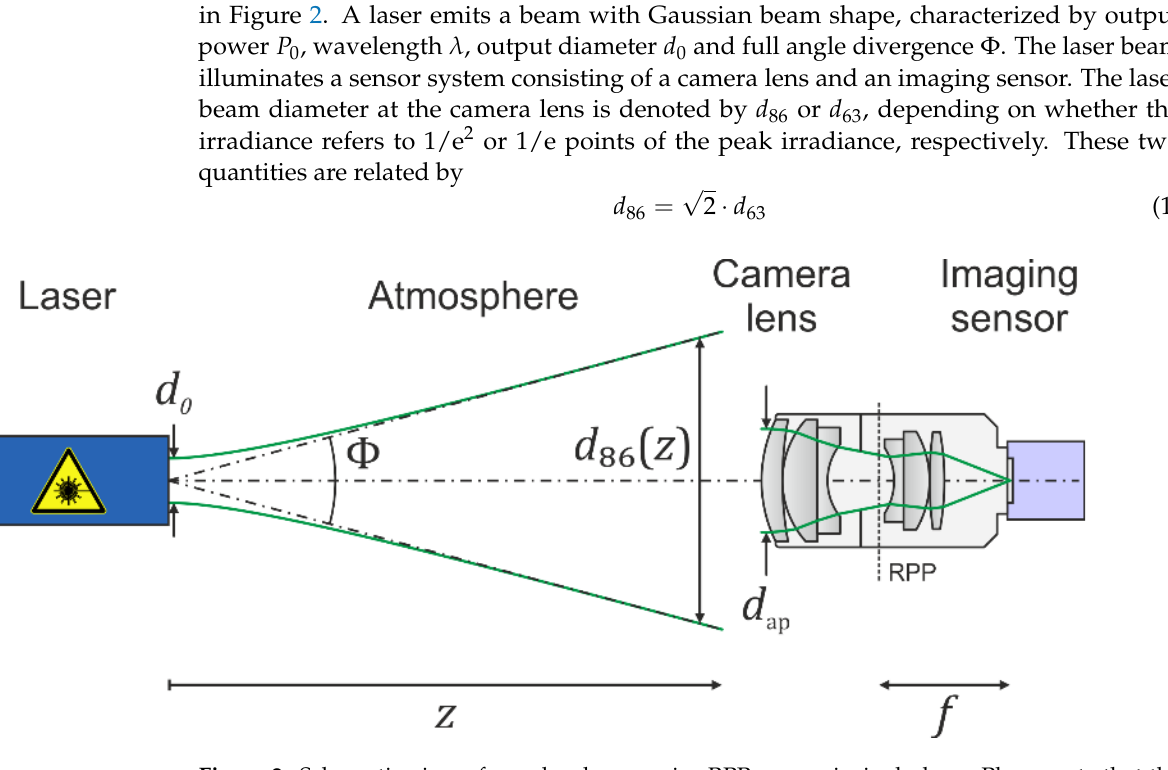
Figure 2. Schematic view of our dazzle scenario. RPP: rear principal plane. Please note that the location and size of the apertures and pupils of the camera lens are drawn for illustrative purposes only. Based on Figure 2 of reference [14].